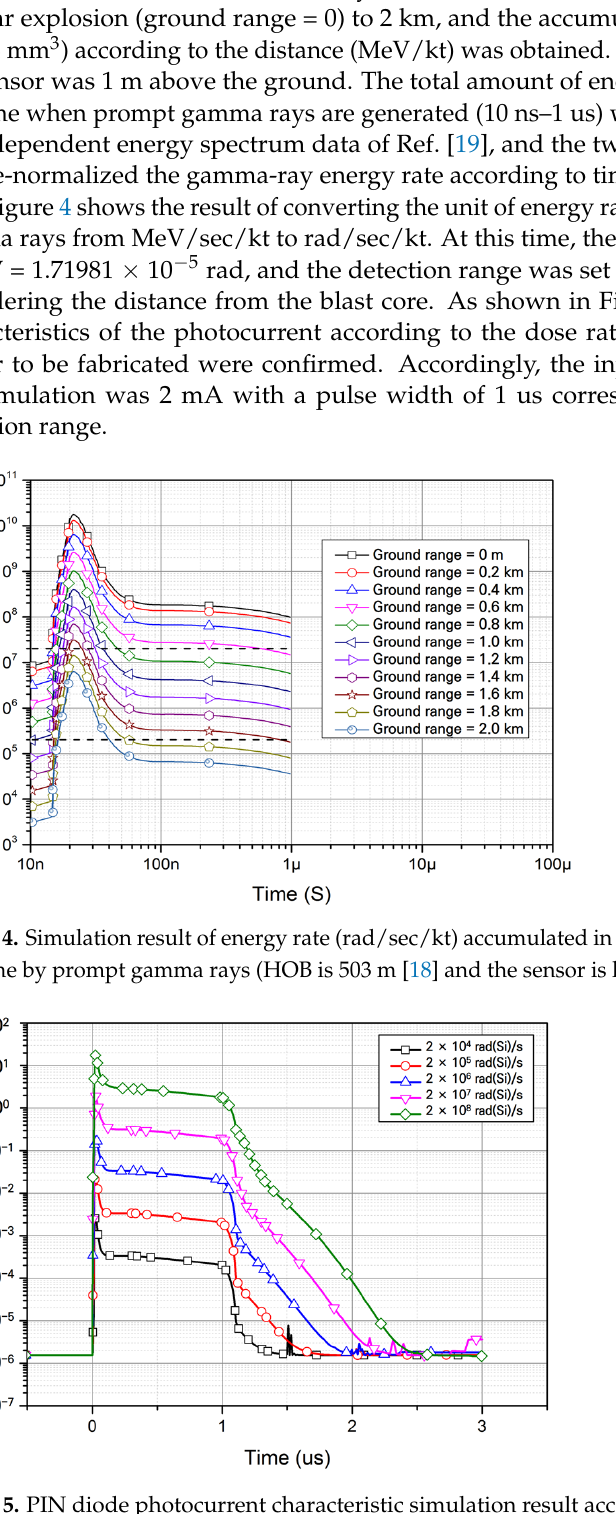
Figure 5. PIN diode photocurrent characteristic simulation result according to the calculated radiation dose.